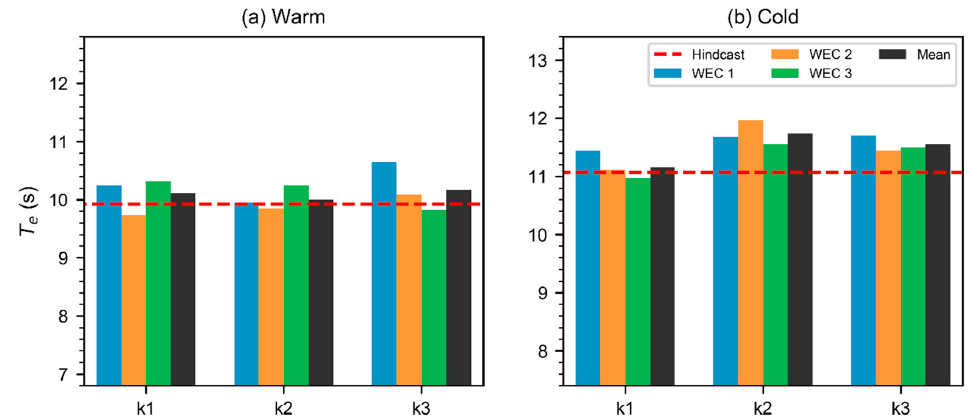
Figure 8. Energy period values computed from FUNWAVE post-processed spectra for the case of ( a ) warm weather and ( b ) cold weather months, compared to hindcast benchmarks.